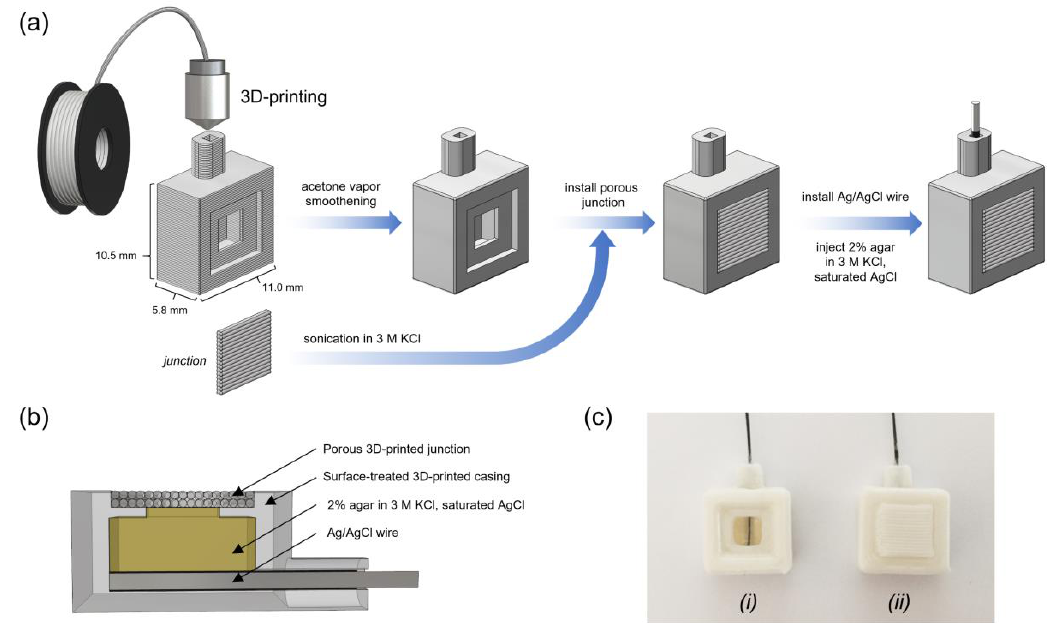
Figure 1. Design and fabrication of 3D-printed reference electrode (3D-RE). ( a ) Scheme illustrating the fabrication process of the 3D-RE. ( b ) Cross-section of the 3D-RE. ( c ) Photograph of assembled 3D-RE ( i ) without a junction installed and ( ii ) with a junction installed.